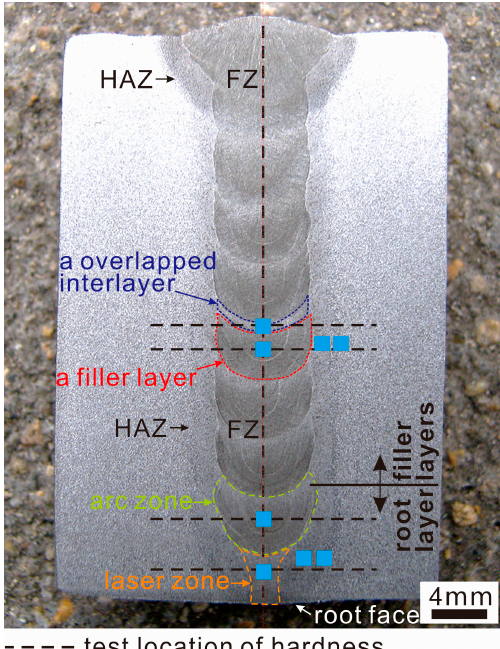
Figure 3. Cross section of 40 mm thick joint created with narrow gap laser-arc hybrid welding (NGHW). The areas for examining microstructure zone are marked by blue cubes and the locations for testing microhardness are marked by dash lines.